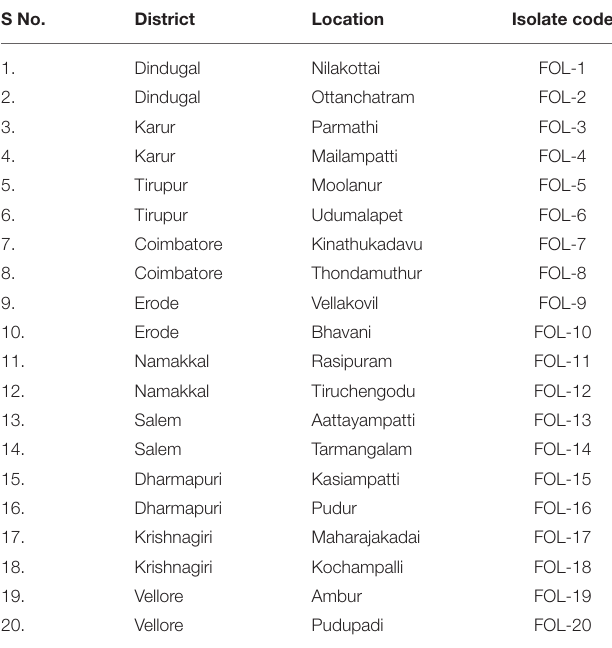
TABLE 1 | List of Fusarium oxysporum f.sp. lycopersici isolates from different places of Tamil Nadu. S